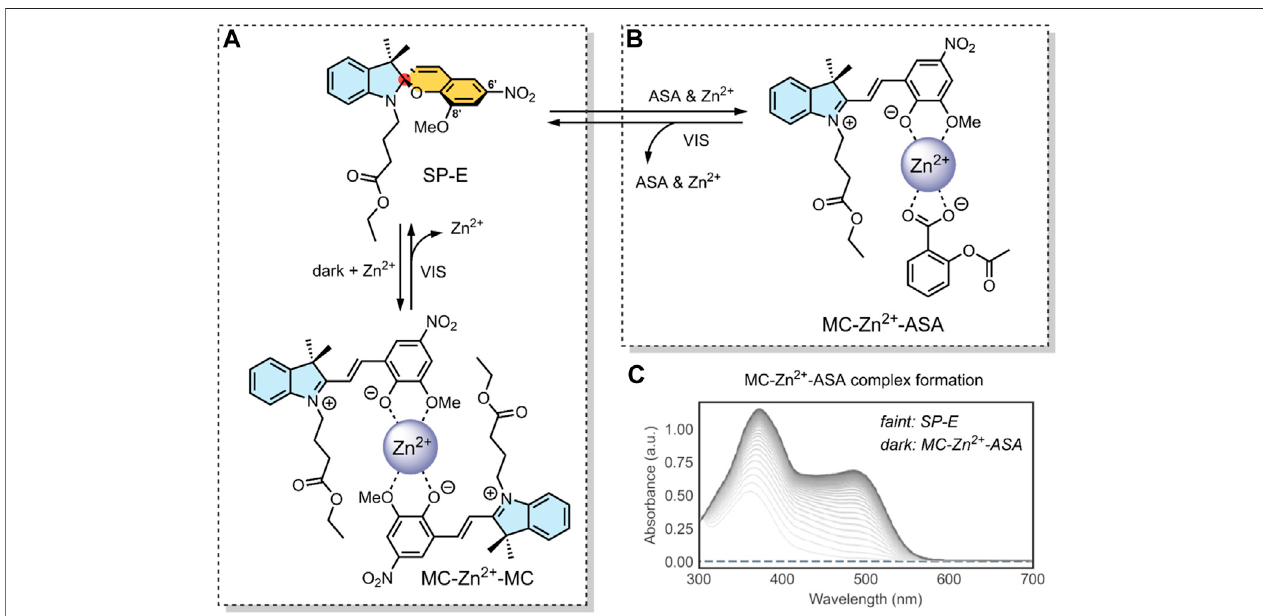
FIGURE 5 | (A) Schematic of our SP-derivative, SP-E, with its 6 ′ nitro and 8 ′ methoxy groups; and the MC-Zn 2+ -MC complex, where MC is shown to chelate with Zn 2+ throughitsphenolateandmethoxyoxygens(Baldrighietal.,2016).Thespiro-carbon,indolineheterocycle,andbenzopyranhavebeenhighlightedinred,blue,and yellow. (B) SchematicoftheternarysupramolecularDDS,MC-Zn 2+ -ASA,designedbyourgroupforreversibleVISlight-triggereddualAPIrelease(Cardanoetal.,2019). (C) UV-VIS absorption kinetics study of the MC-Zn 2+ -ASA ternary complex reformation ( faint grey to dark grey ) after a VIS-induced API release into solution, as measured in acetonitrile over 3 h immediately after irradiation, in the dark. The band at 490 nm is the λ max of MC in MC-Zn 2+ -ASA; SP-E does not absorb in this wavelength (Cardano et al., 2019). Figure C. adapted with permission from the Royal Society of Chemistry (Cardano et al.,